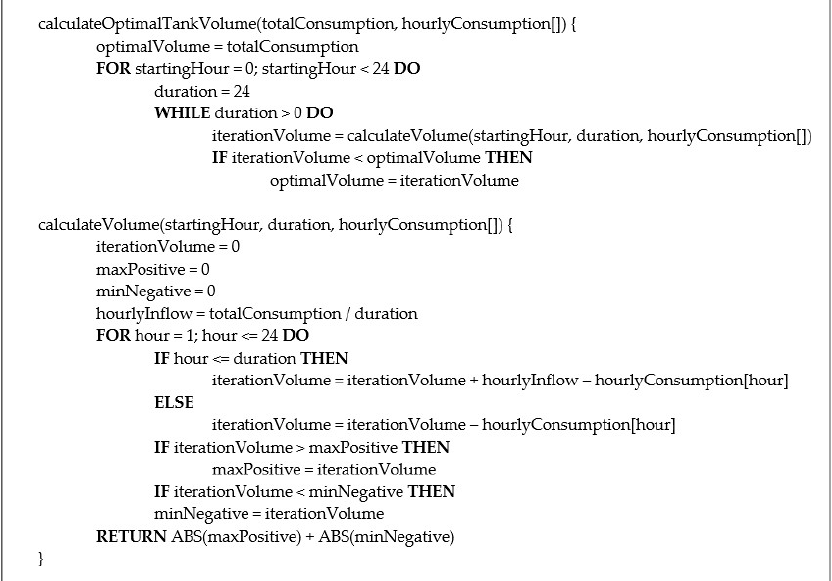
Figure 2. Pseudocode 1—calculation of the minimum required tank volume.